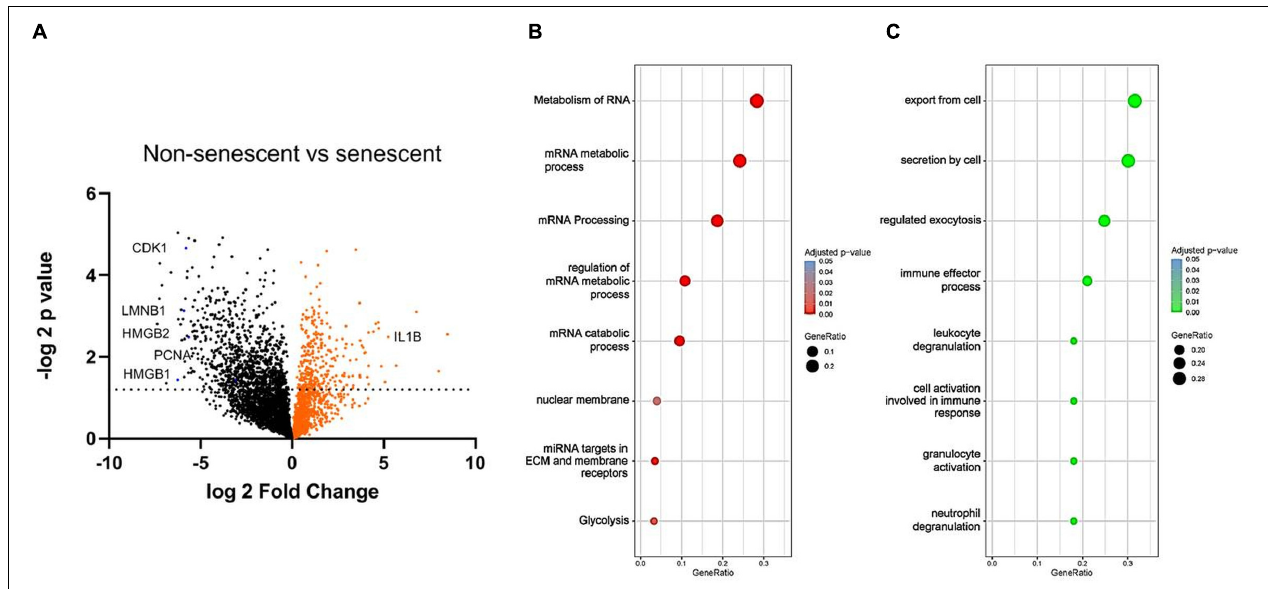
FIGURE 4 | (A) Volcano plot of NS and RS VSMC protein expression measured by LC-MS. False discovery rate was set at 0.01, n = 3, t -test. Gene ontology analysis via the g:Profiler tool of (B) downregulated and (C) upregulated processes in RS, t